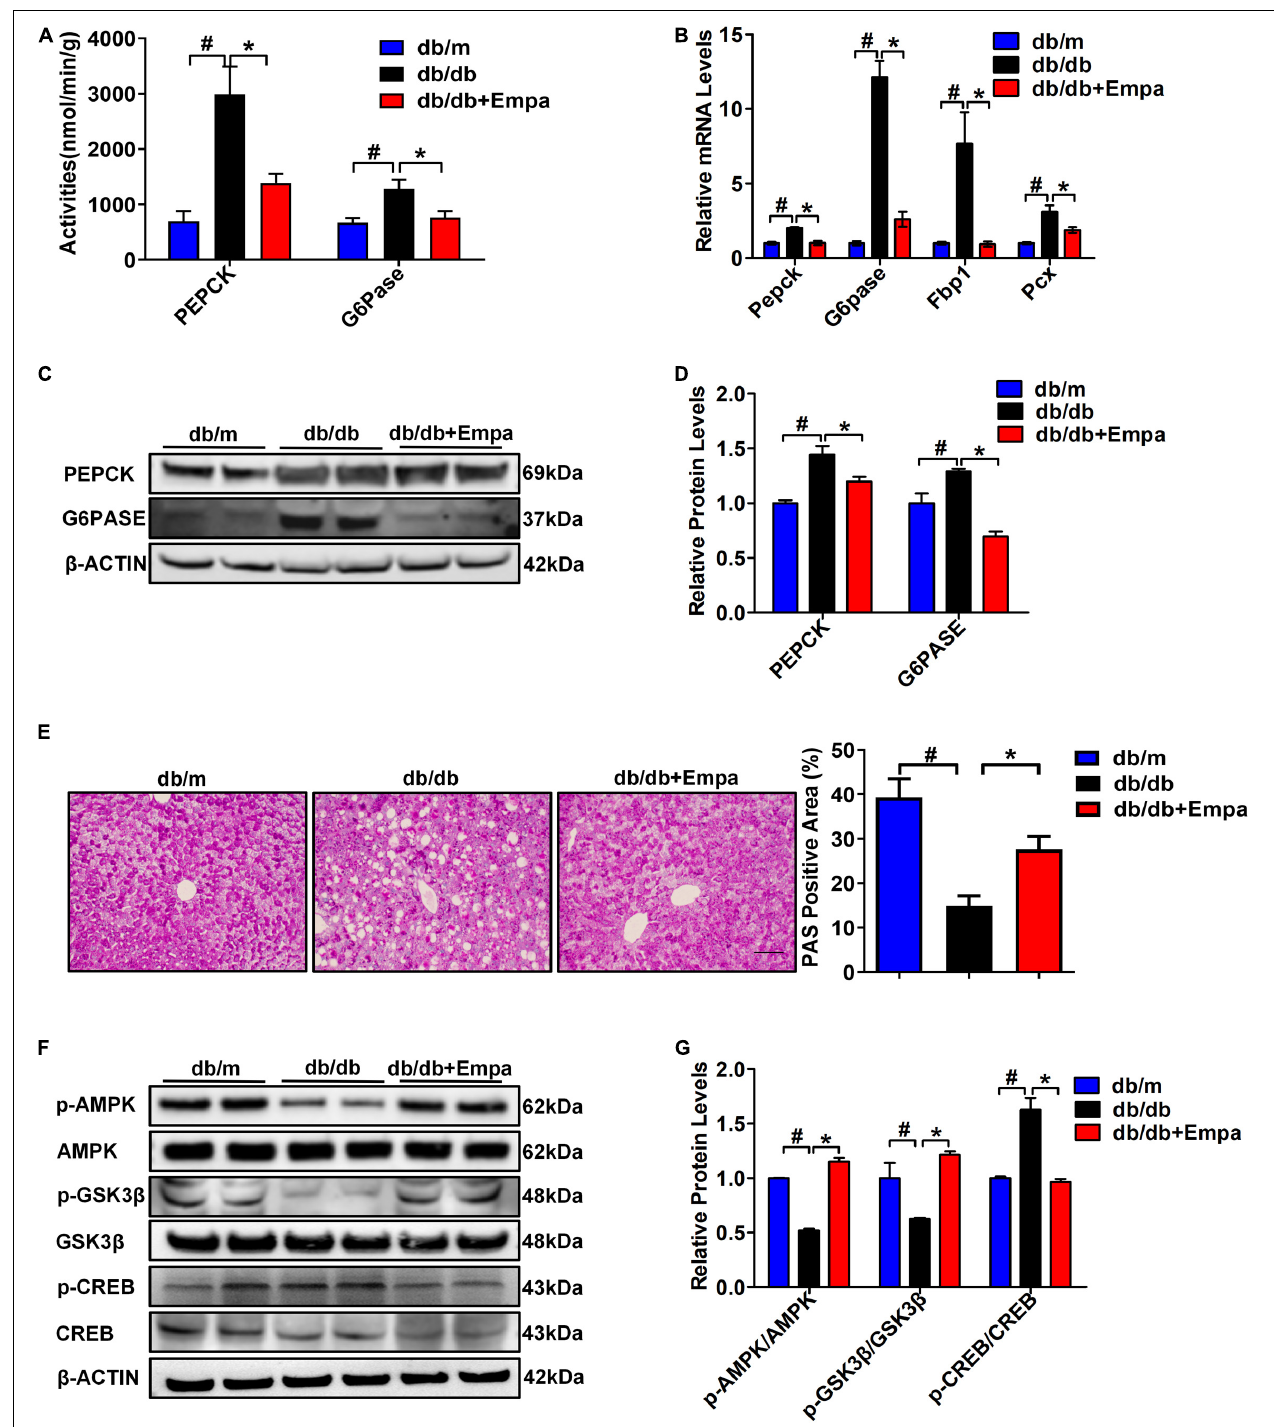
FIGURE 2 | Empagliflozin partially suppressed hepatic gluconeogenesis and promoted glycogen synthesis. (A) Activities of PEPCK and G6Pase in hepatic tissues ( n = 6 samples/group). (B) Relative mRNA expression levels of Pepck , G6pase , Pcx, and Fbp1 in the liver were measured by RT-PCR ( n = 6 samples/group). (C) Relative protein expression levels of PEPCK and G6PASE in the liver were determined by western blotting. (D) Protein quantitative statistics ( n = 6 samples/group). (E) Hepatic PAS staining, scale bar = 100 µ m ( n = 6 samples/group). (F) Relative protein expression levels of p-AMPK, AMPK, p-GSK3 β , GSK3 β , p-CREB, and CREB in the liver were determined by western blotting. (G) Protein quantitative statistics ( n = 6 samples/group). * P < 0.05, db/db vs. db/db+Empa; # P < 0.05, db/db vs. db/m.